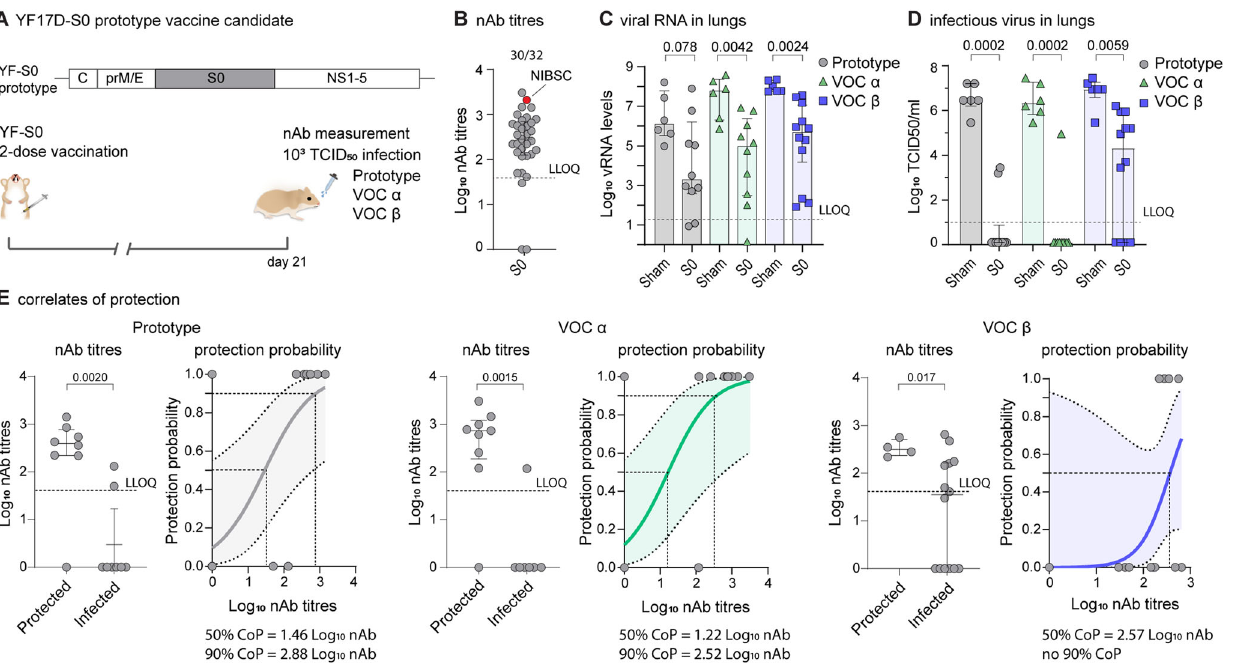
Fig. 1 | Immunogenicity and protective ef fi cacy of fi rst-generation Spike vac- cine against prototype SARS-CoV-2 and VOCs Alpha and Beta. A Vaccination scheme with prototypic YF17D-based vaccine candidate YF-S0 (S0). Syrian ham- sters ( n =32 vaccinated and n =18 sham vaccinated) were immunized twice intra- peritoneallywith10 4 PFUofS0onday0and7andinoculatedintranasallyonday21 with 10 3 median tissue-culture infectious dose (TCID 50 ) of either prototype SARS- CoV-2(graycircles, n =10YF-S0and n =6sham),VOCAlpha(greentriangles, n =10 YF-S0 and n =6 sham), or VOC Beta (blue squares, n =12 YF-S0 and n =6 sham). B nAb titres against prototypic spike (D614G) pseudotyped virus on day 21 after vaccination, 30/32 indicates the seroconversion rates. Red datapoint indicates the